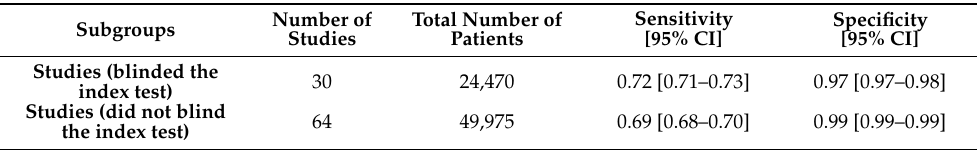
Table 5. Comparative performance of studies that blinded the index test and studies that did not blind the index